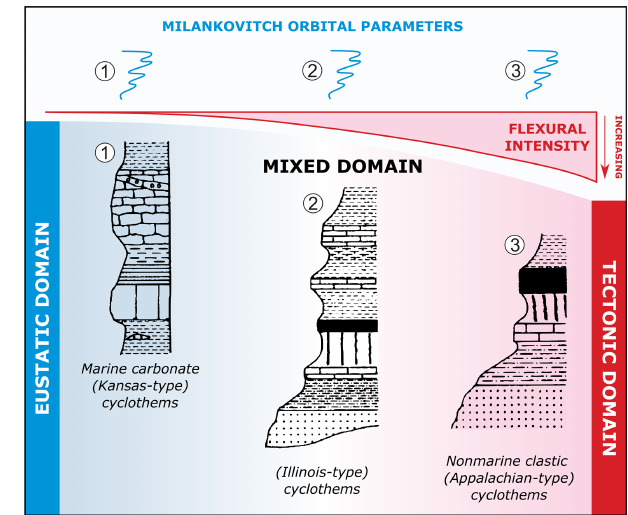
Figure 20. The genesis of the different types of cyclothems in North America related to orbital parameters and lateral differences in the crust’s flexural intensity (modified from Klein and Willard, 1989).